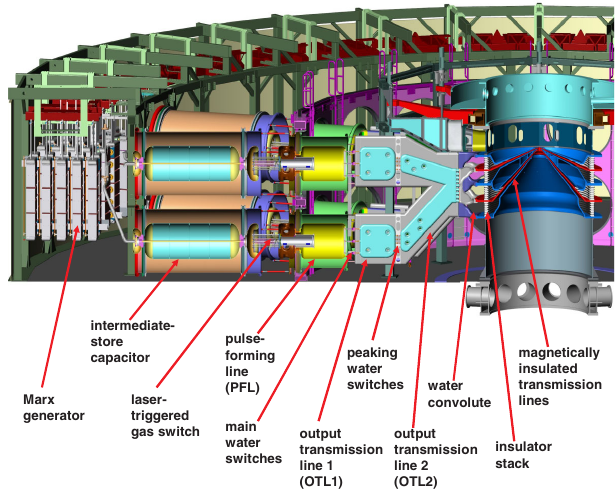
FIG. 1. (Color) Cutaway view of the ZR accelerator at Sandia National Laboratories. Principal components of the accelerator are